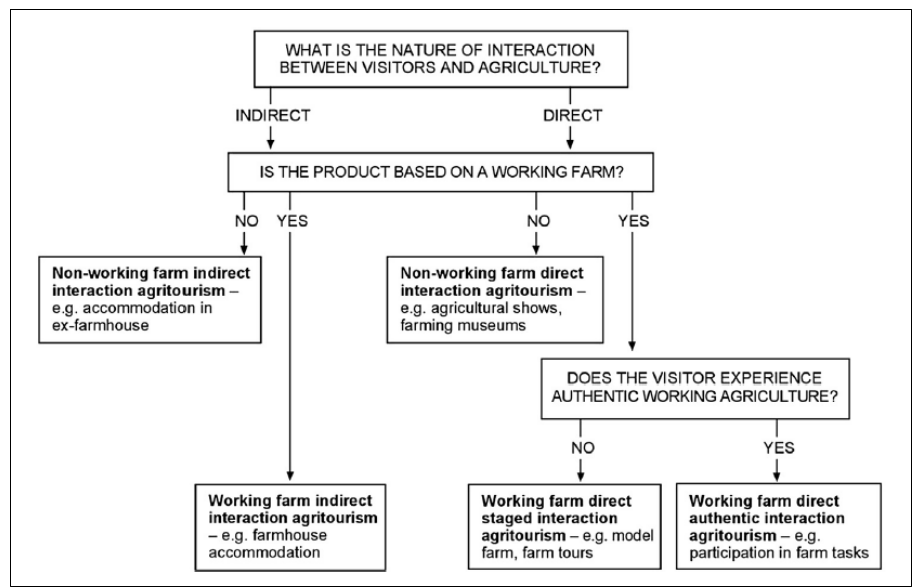
Source: Phillip, Hunter, & Blackstock Figure 2. A Revised Typology for Defining Agritourism